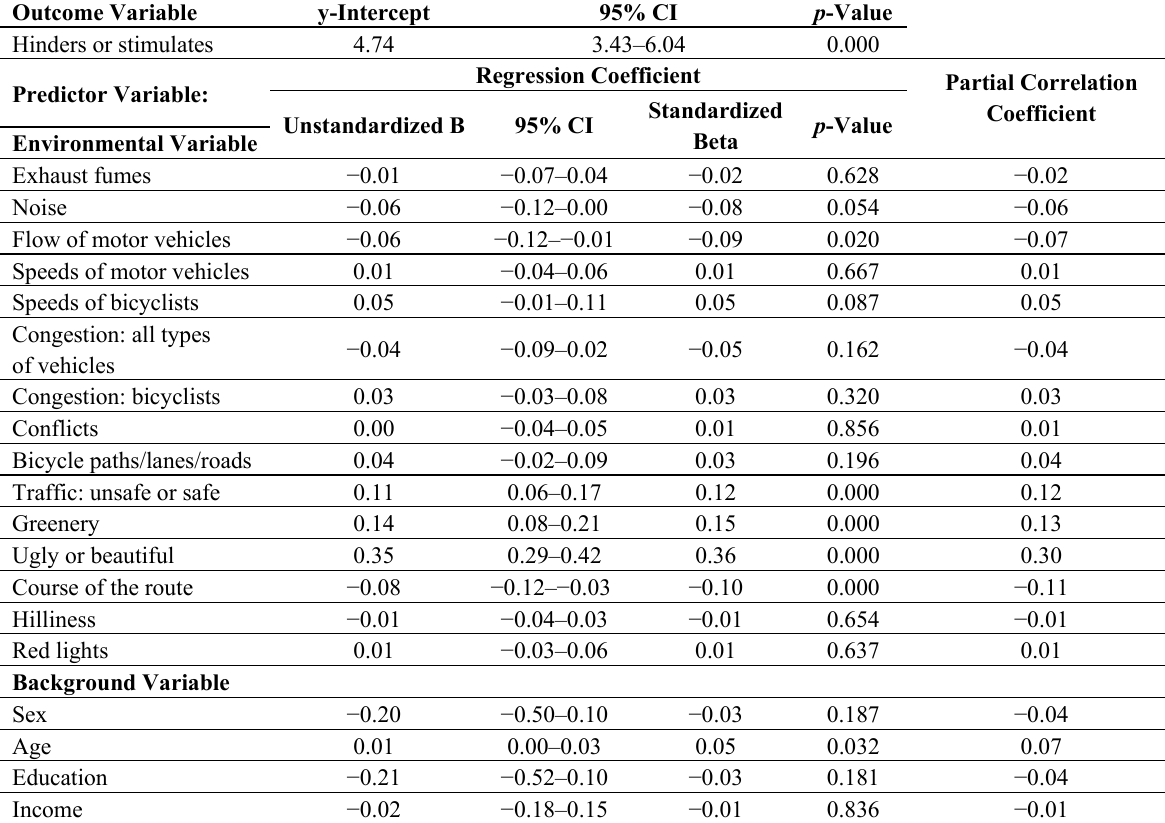
Table 7. Model 2, in which the item traffic: unsafe or safe was included: Simultaneous multiple regression analysis of route environment and background variables (n =